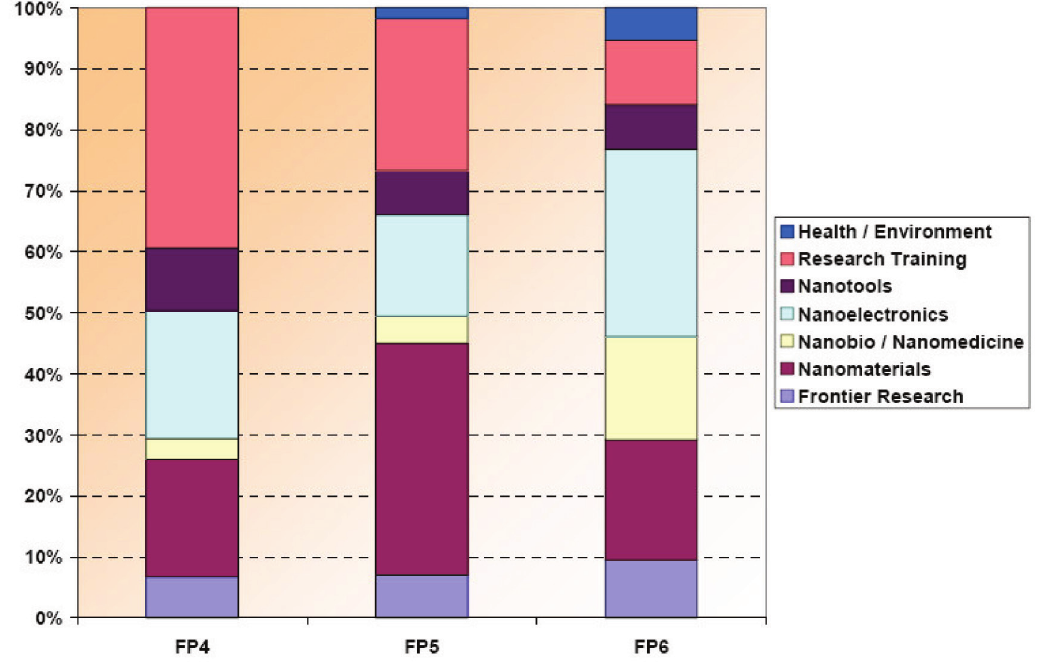
FIGURE 2 – Areas of R&D in Nanotechnology supported by successive FPs. Source: Unit G4,